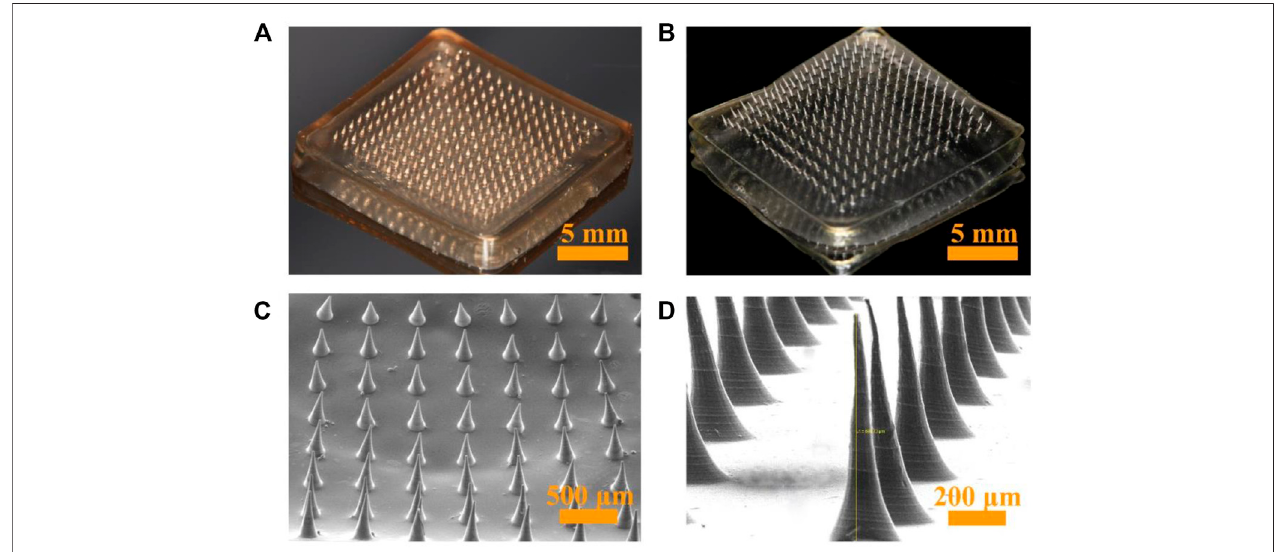
FIGURE 2 | Optical and SEM photographs of KCFMN and CFMN. (A) Optical photograph of KCFMN. (B) Optical photograph of CFMN. (C) SEM photograph of KCFMN. (D) Magni fi ed SEM photograph of the individual MN. Scare bars: 5 mm in (A) and (B) , 500 μ m in (C) , 200 μ m in (D) .